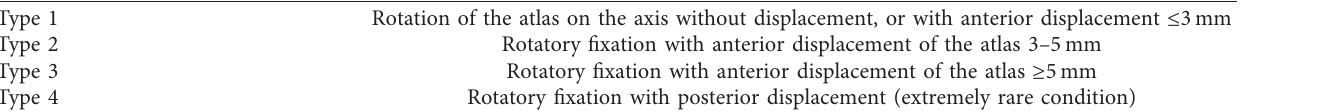
Table 1: Fielding–Hawkins classification.